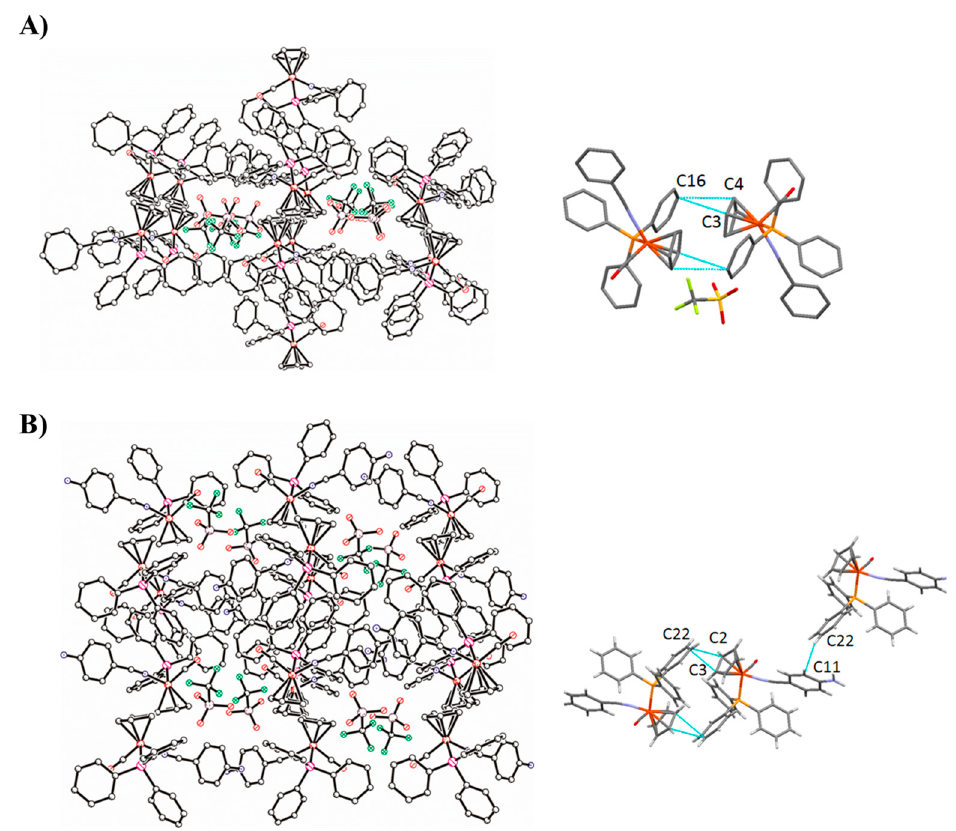
Figure 4. Crystal packing of the compounds ( A ) [Fe(η 5 -Cp)(CO)(PPh 3 )(NCPh)][CF 3 SO 3 )] 1 and ( B ) [Fe( η 5 -Cp)(CO)(PPh 3 )( p -NCPhNH 2 )][CF 3 SO 3 ] 4 (left; drawing were done with SHELXTL program in balls and sticks). Short contacts between complexes are showed in dashed blue lines (right) (drawings were done with mercury 3.7 program in capped sticks). Hydrogen atoms are omitted for clarity.